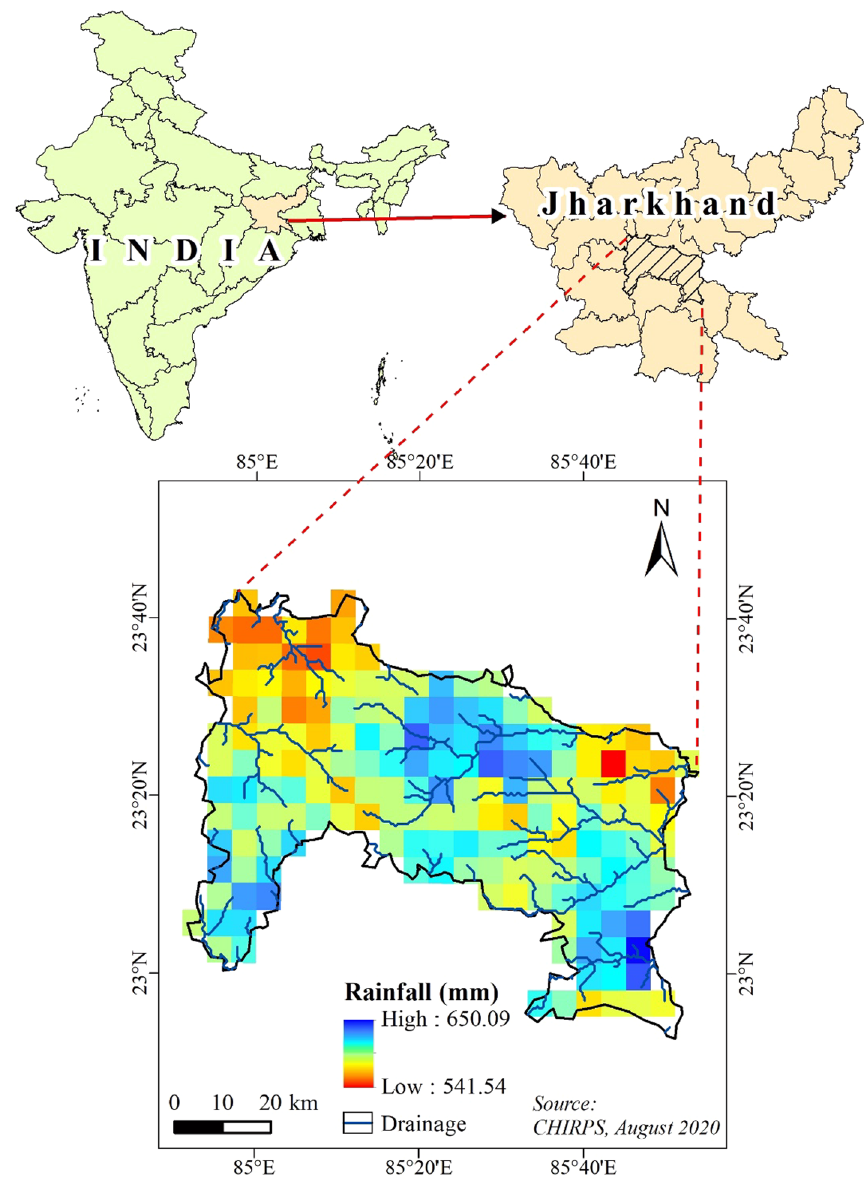
Fig. 1 Location map of the study